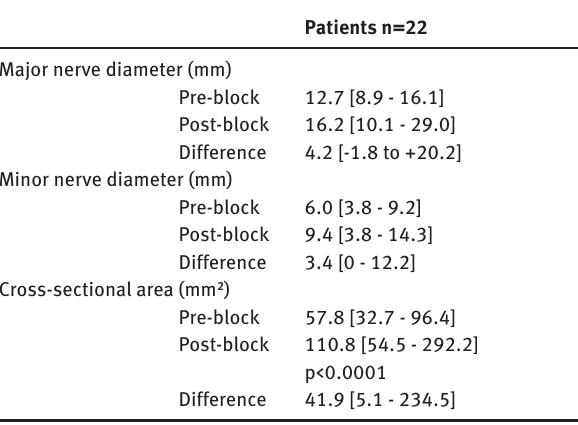
Table 3: Ultrasound dimensions of the SN (median [range])